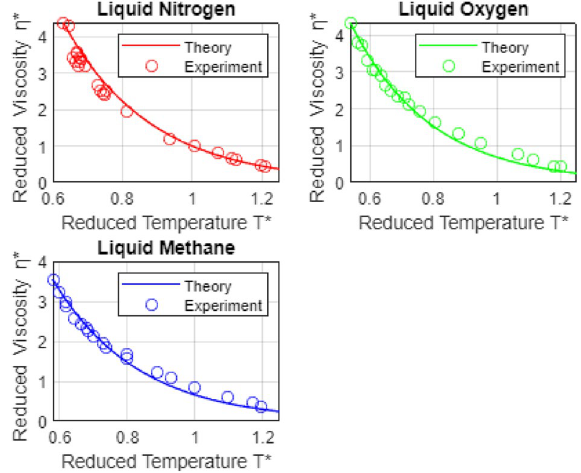
Figure 2. Temperature-dependent liquid viscosities for liquid N 2 , O 2 , and CH 4 . Notes (a) Experimental , where √ M κ ǫ min , κ σ 2 viscosity for specie κ is nondimensionalized using the viscosity scale µ scale , κ min , κ = ǫ min , κ , is the minimum Lennard-Jones potential, σ min , κ , is the molecular separation at which the potential is minimized, and M κ is the molecular mass. Likewise, nondimensional experimental temperatures are scaled ǫ min , κ / k B , where k B is Boltzmann’s constant. (b) The minimum temperature, T min , κ , at which using T scale , κ = each specie viscosity was measured corresponds approximately to the melting temperature (at atmospheric pressure) for that specie. c) The maximum measurement temperature for each specie, T max , κ , in all six cases, exceeds the specie’s atmospheric boiling point. Thus, the viscosities shown exceed the range of temperatures over which each specie is in the liquid state. Sources for the experimental viscosity data shown are as follows: N 2 55 ; O 2 55 . For a discussion of estimated experimental uncertainties, please see the